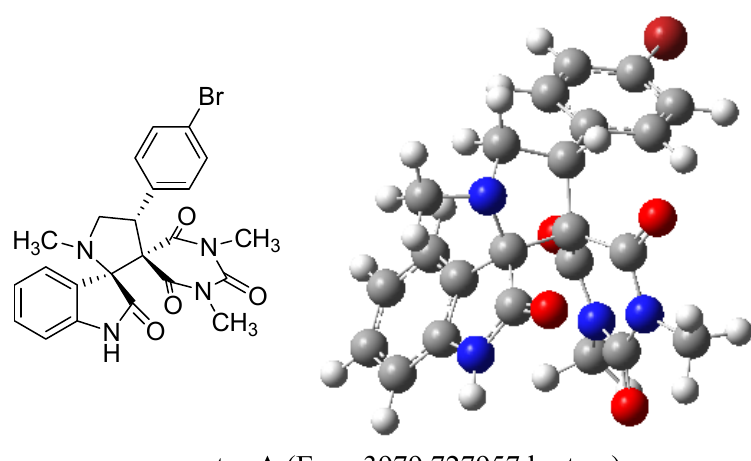
Figure 1. Optimized geometry of 4a